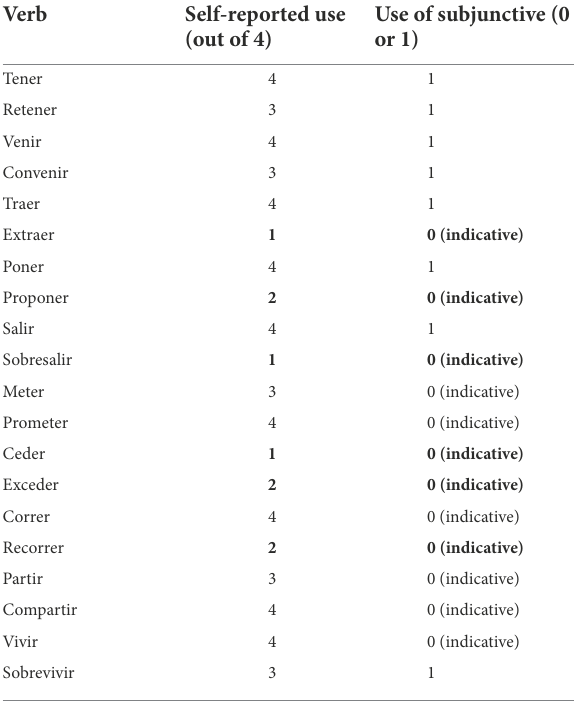
The bolded rows indicate verbs that participants reported using